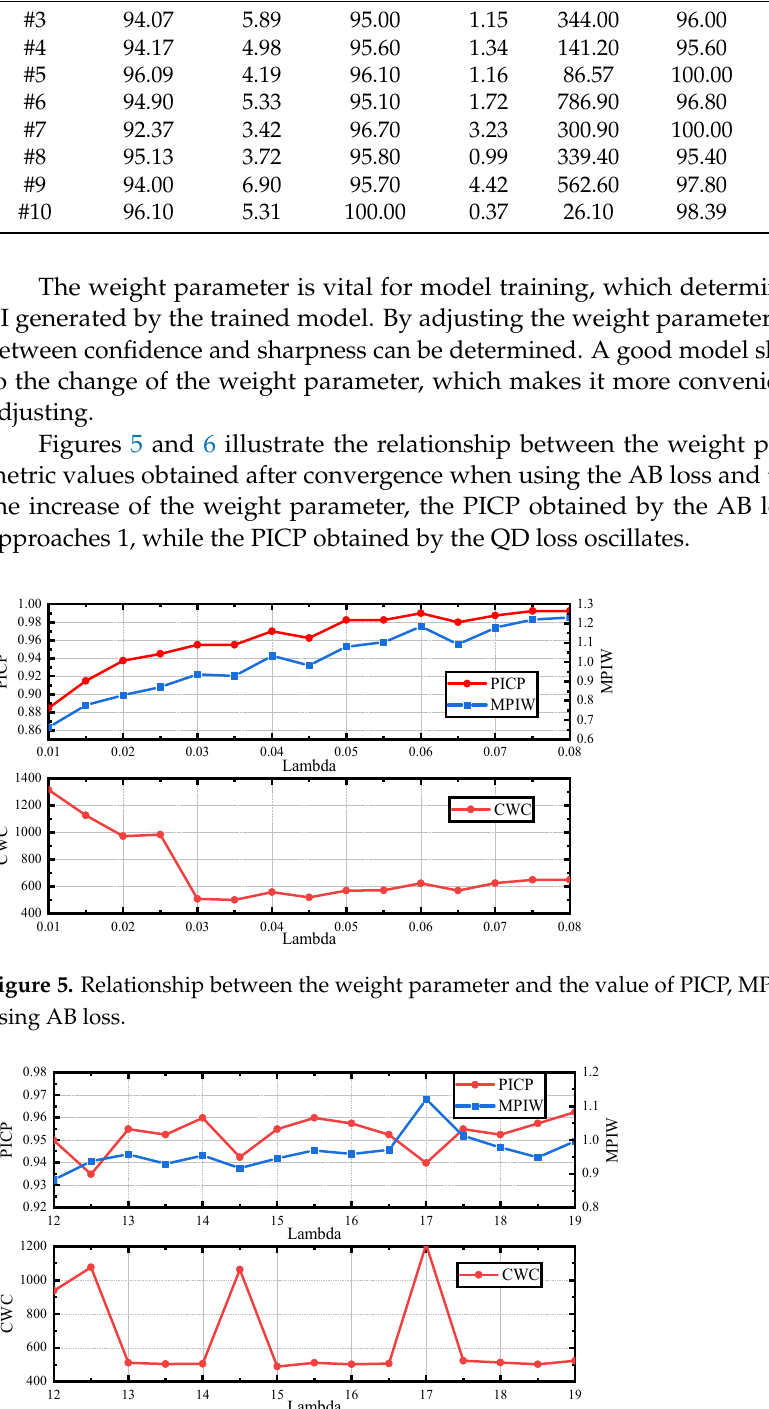
Table 4. Statistical characteristics of PICP, MPIW and CWC for the LUBE method, the QD loss and the AB loss in 8 benchmark experiments.